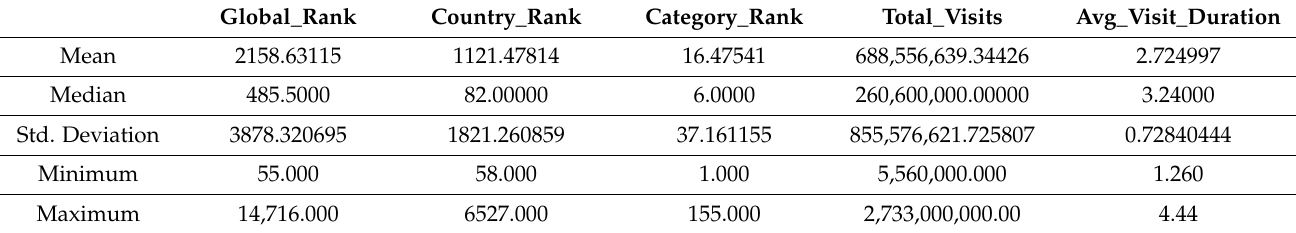
Table 3. Descriptive statistics for web analysis